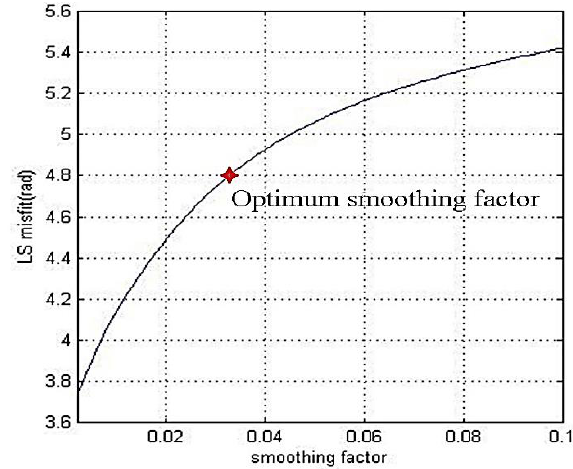
Fig 2 . Optimum smoothing factor selected at the elbow of the curve. Horizontal and vertical axes represent the smoothing factor and least-squares misfit,